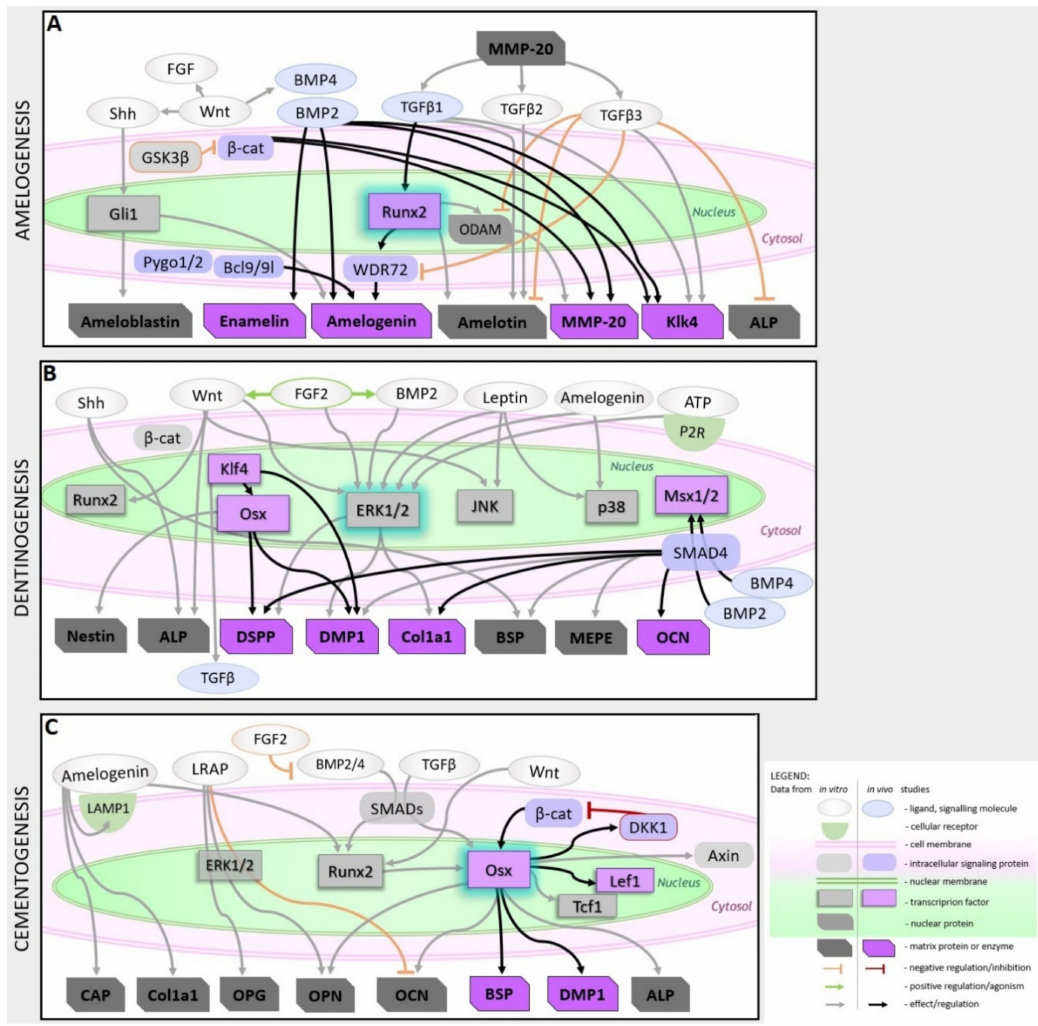
Figure 2. Major signaling cascades involved in amelogenesis, odontogenesis, and cementogenesis. ( A ) Signaling pathways modulating amelogenesis with TGF- β superfamily ligands (BMP2 and TGF- β 1 / 2 / 3) playing the major role in matrix protein and metalloproteinases feedback-regulation and Runx2 being an important transcription factor. ( B ) Central signaling cascades of odontogenesis are depicted. The TGF- β superfamily ligands (BMP2 / 4 and TGF β s) regulate many odontogenic genes with ERK1 / 2 as convergence point and Klk4-Osx as important transcription factor tandem. ( C ) Major cementogenesis-related signaling cascades with Osx as the central transcription factor being regulated via Wnt / β -catenin in a feedback-loop. Ameloblast-derived products (LRAP and amelogenin) were shown modulate key cementogenic gene expression in